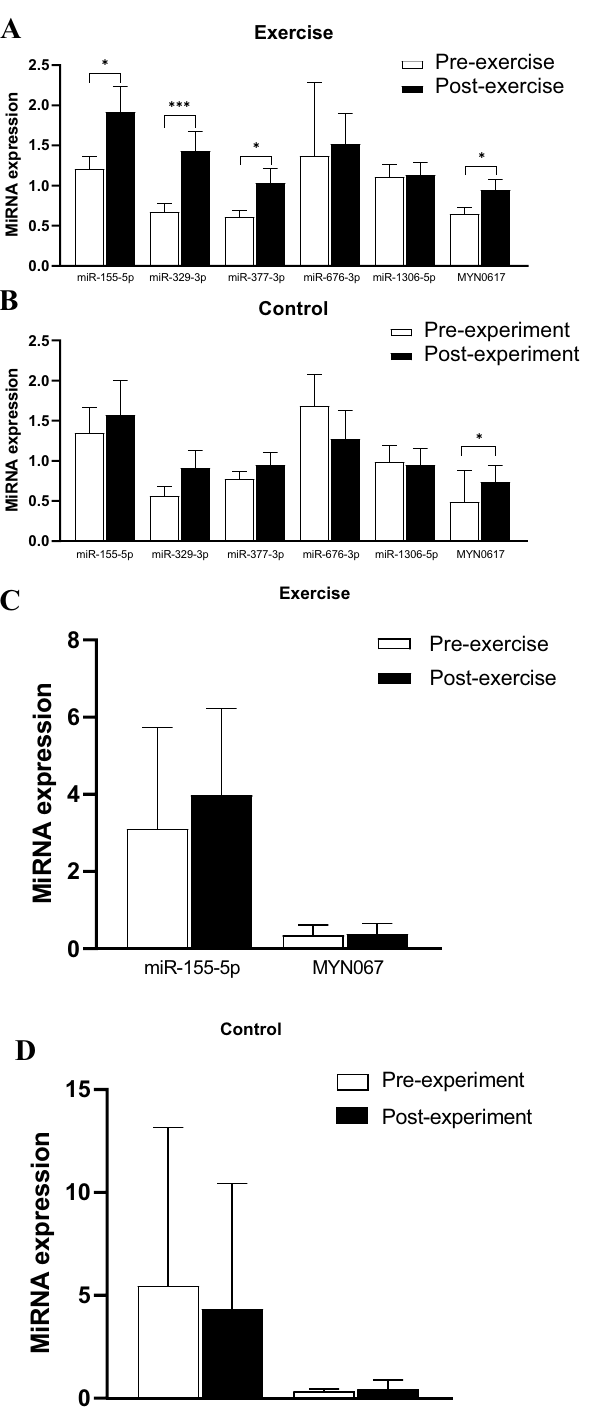
Figure 1. MiRNA expression in GSAT in the exercise training ( A ) and control ( B ) groups, and in ASAT in the exercise training ( C ) and control ( D ) groups. MiRNA expression was quantified using TaqMan qRT-PCR. Results are expressed as the mean ± SD (exercise group n = 19; controls n = 12). *p < 0.05, ***p <